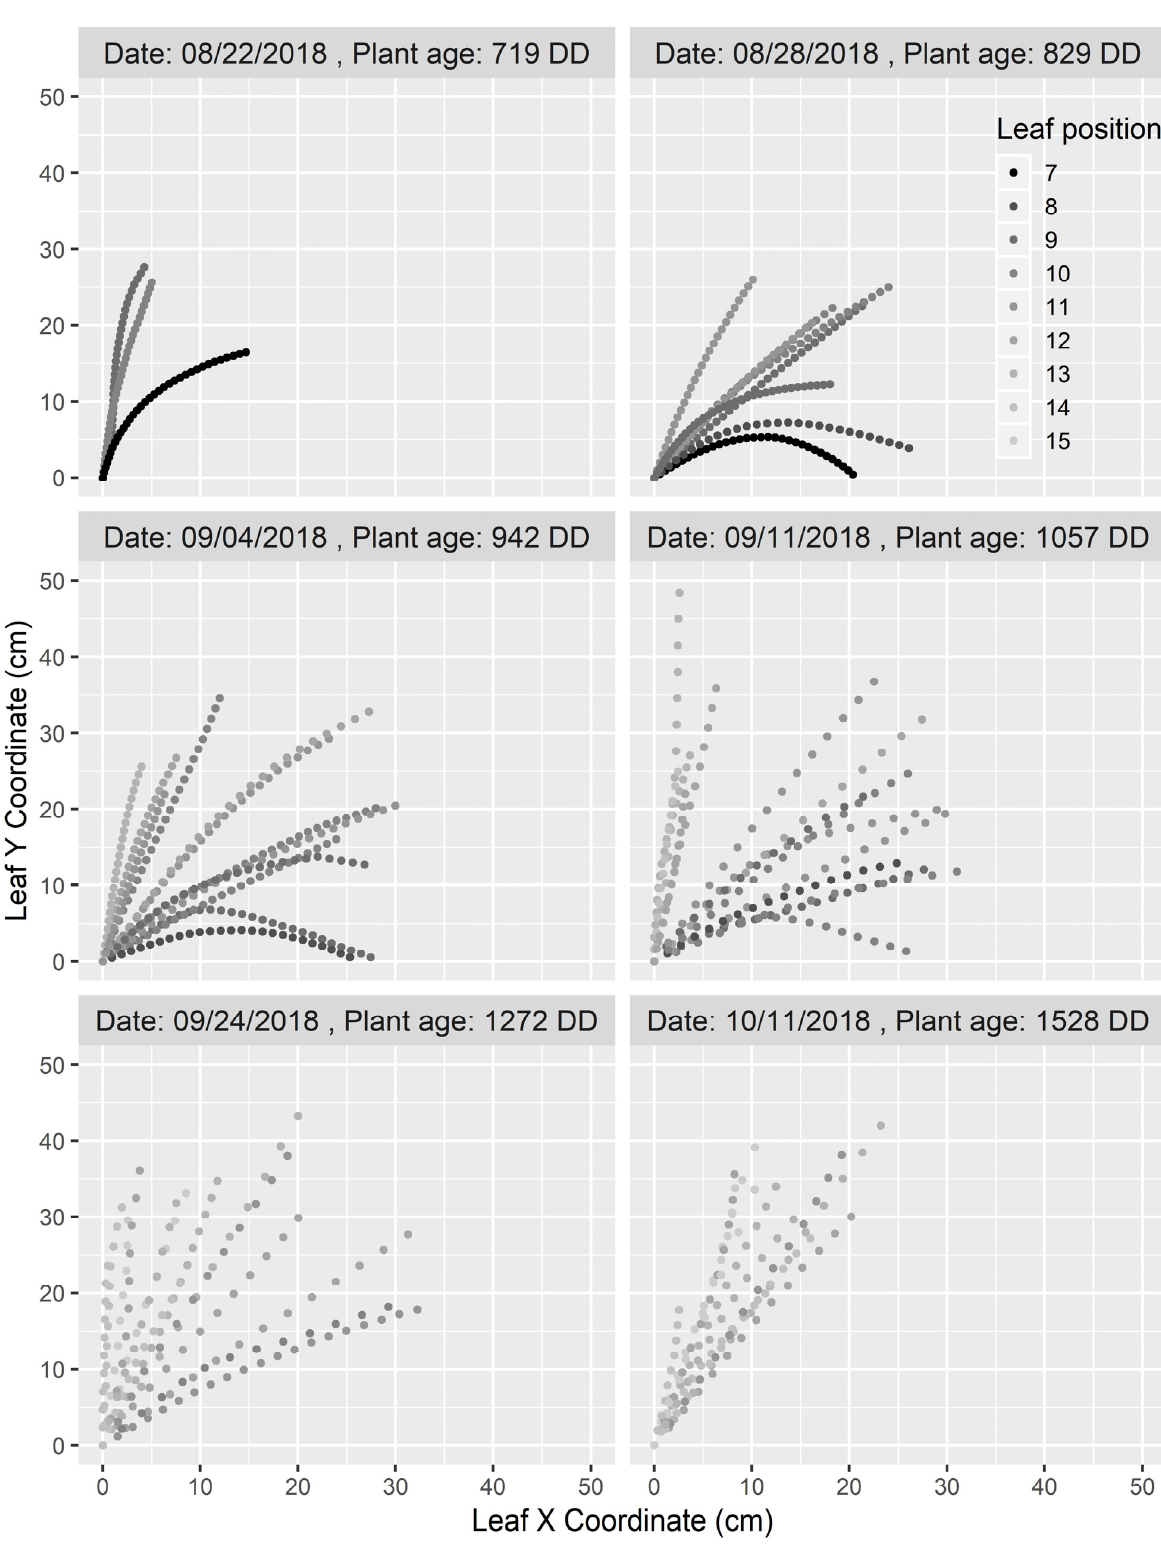
Figure 3. Rice leaf insertion and curvature in relation to plant age and leaf position for hybrid genotype 212S/173R in 2018 (leaves of three plants at the density of five plants per meter row), which were captured by tracing leaves using PocketPlant3D. Plant age DD was calculated as cumulative degree-days from sowing above a base temperature of 10 °C.